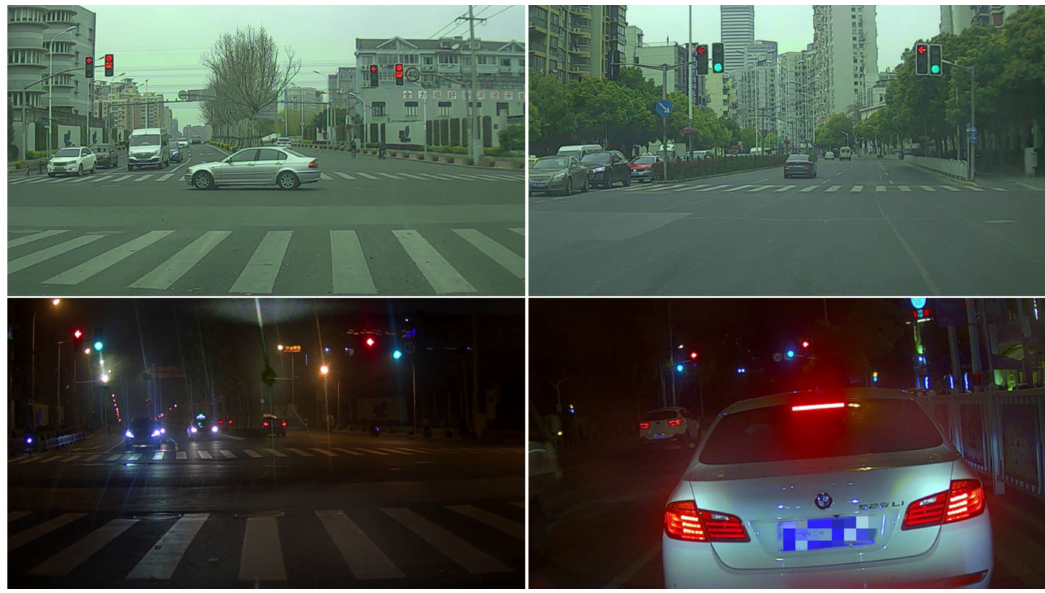
Figure 7. Example images of S 2 TLD